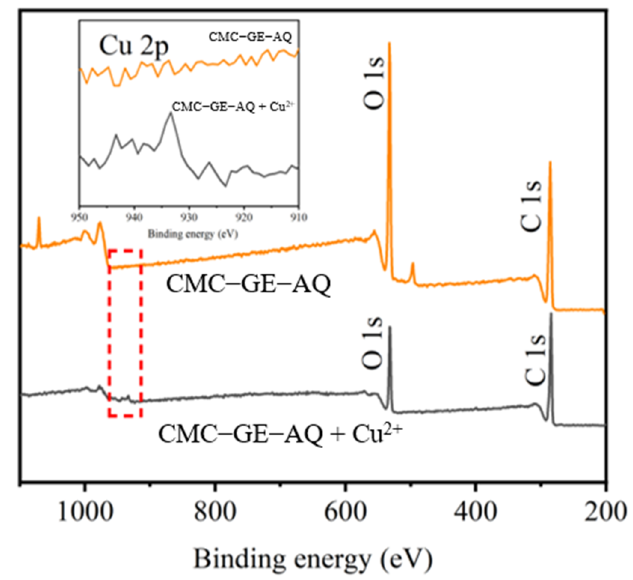
Figure 9. The XPS spectra of the CMC−GE−AQ and CMC−GE−AQ + Cu 2+ complexes. According to the high−resolution XPS spectra of O 1s (Figure 10a,b). The three absorptions at 532.3, 533.0 and 533.9 eV originated from the absorptions of O=C−O, C−O−C/C−O−H and O=C−O−C, respectively. Compared with CMC−GE−AQ and the CMC−GE−AQ + Cu 2+ complex, C−O−C/C−O−H contents at 533.0 eV decreased and O=C−O−C contents at 533.9 eV markedly decreased. It can be concluded that the oxygenic groups structure of CMC−GE−AQ was involved in the complexation with Cu 2+ . The CMC−GE−AQ could be divided into three main absorptions at 398.7, 400.2 and 401.7 eV respectively, corresponding to C=N, C−N and N−H bonds, respectively. After the reaction with Cu 2+ , the peak strength of the C=N and N−H bonds weakened, indicating that the N atom of the CMC−GE−AQ was involved in the complexation of Cu 2+ .